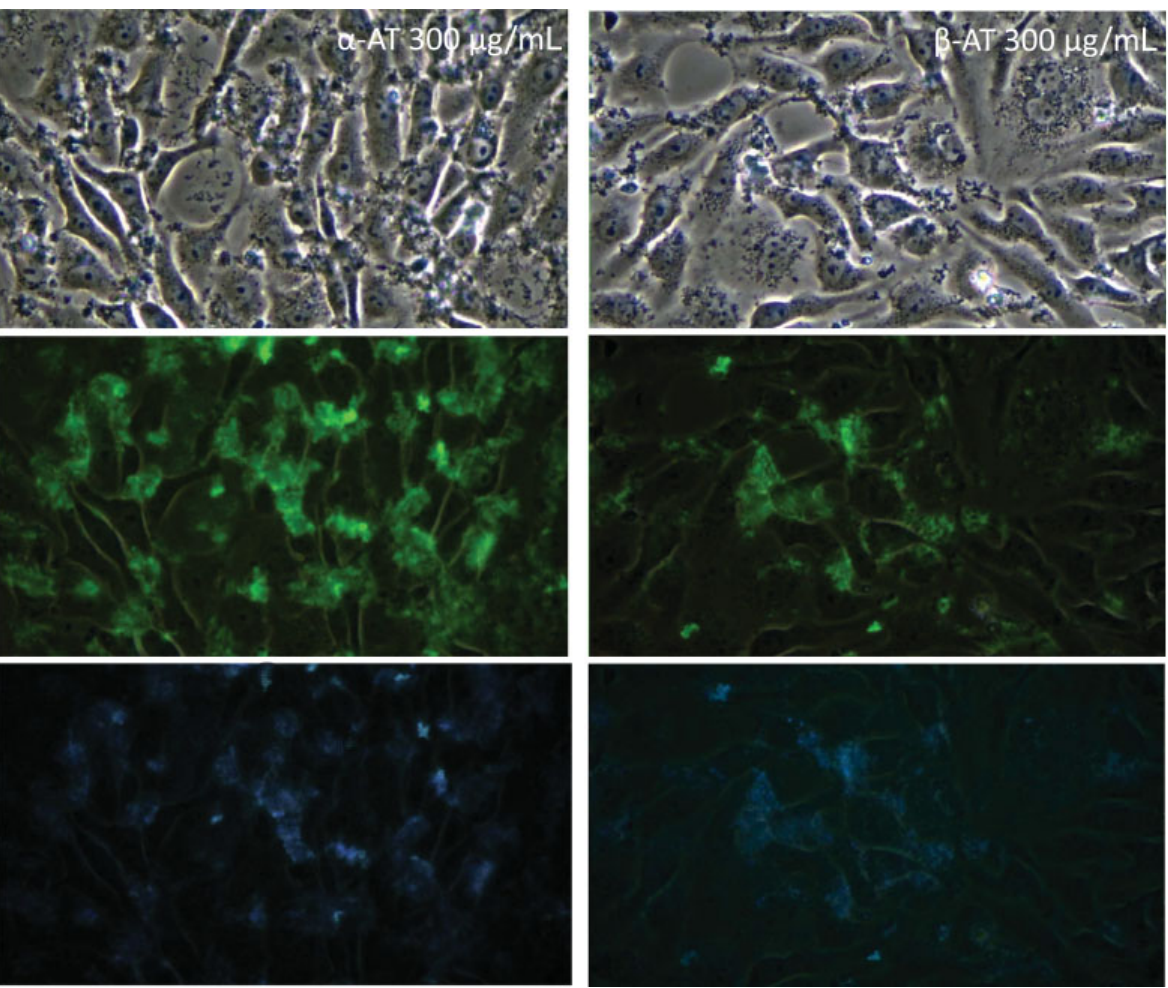
Fig. 4 Phase-contrastandimmuno fl uorescent viewsofstainingforsyndecan-4andantithrombin.Culturedendothelialcellsweretreatedwith35 μ g/mLof histoneH4and300 μ g/mLofeither α - or β -antithrombin. Theupper panels showrepresentative images ofa phase-contrast view of the endothelial cellsat 8 hours. The middle and lower panels show endothelial cells stained with either anti-syndecan-4 antibody or anti-antithrombin antibody. Syndecan-4 and antithrombin were located at the same position. Syndecan-4 staining was more intense with the treatment of α -antithrombin, while the antithrombin staining seemed almost equal between α - and β -antithrombin. AT,